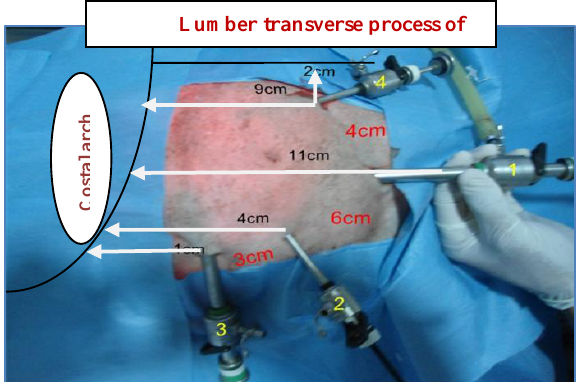
Figure, 1: The ports site for telescope and the other laparoscpic instruments, (10mm) for telescope (1), (5mm) for grasper (2), (10mm) for needle holder or electro- cautery (3) and (10mm) for scissor (4).